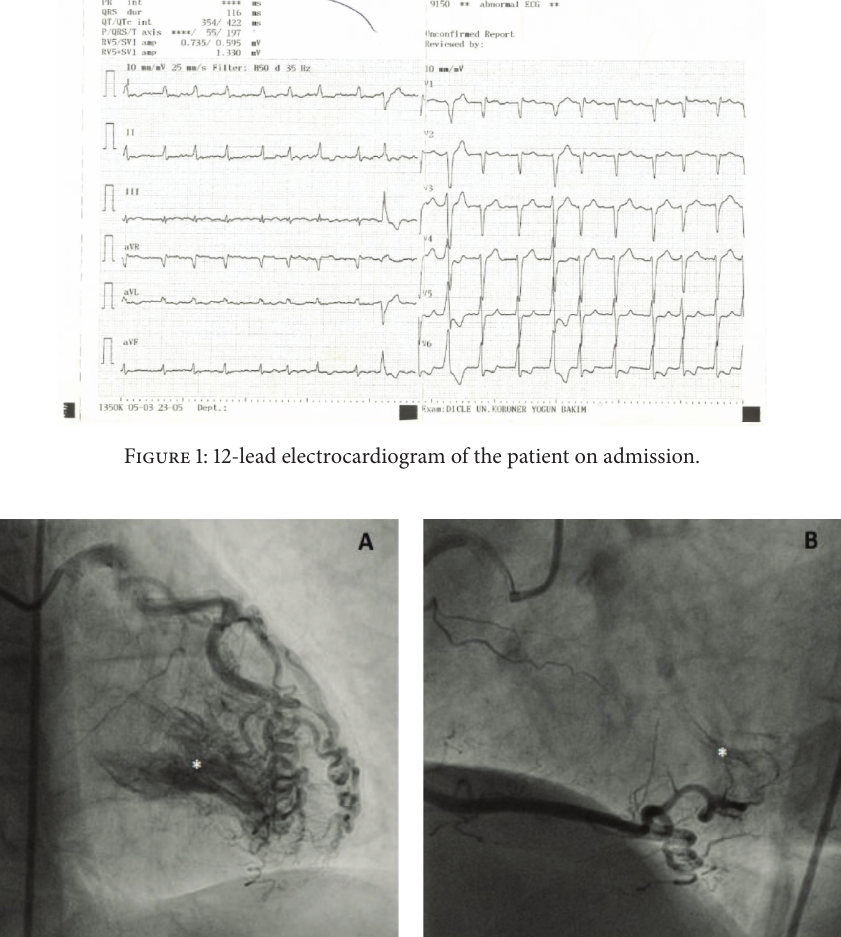
1 and Video 2 in the Supplementary Material